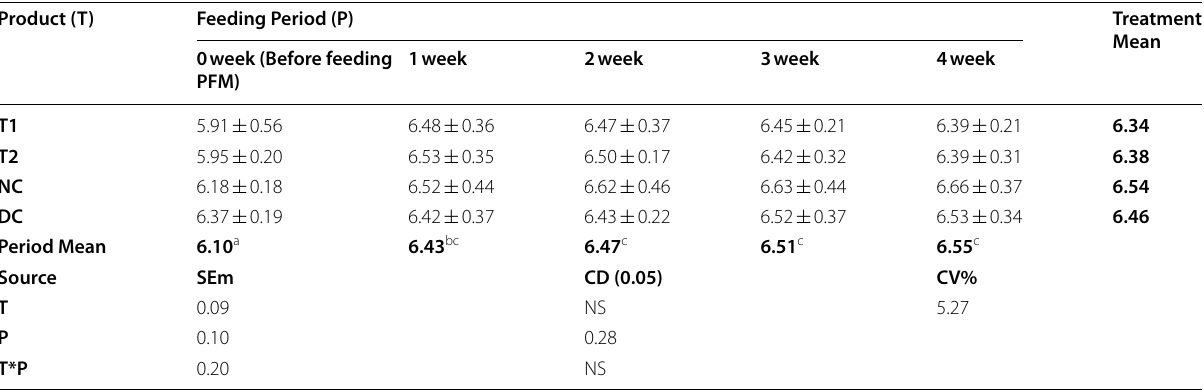
PFM Probiotic fermented milk